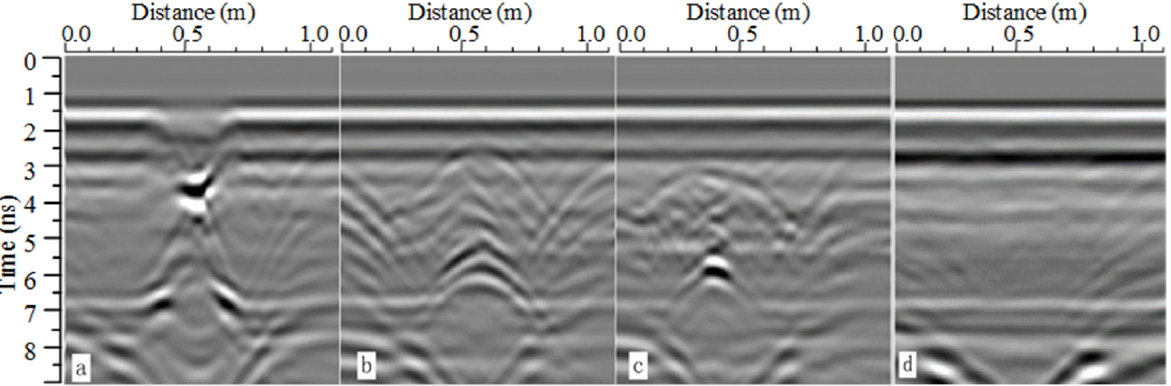
Figure 10. Excavation photos of SWBs corresponding to the GPR’s middle scan line: ( Left ) For a drip irrigation SWB; ( middle ) for a subsurface bubble irrigation SWB; ( right ) for a moistube irrigation SWB.